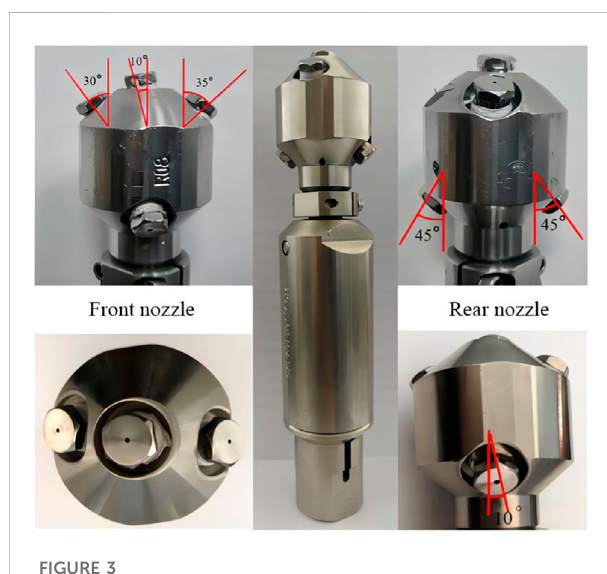
FIGURE 3 Schematic diagram of the self-propelling and rotating